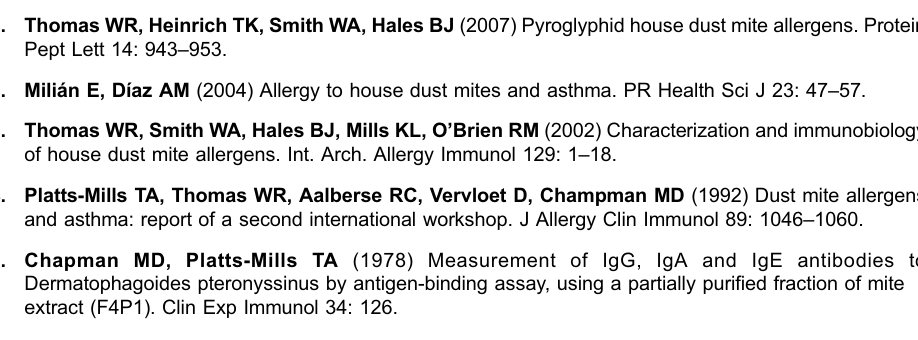
S1 Figure. Selected sequences of the Der f 1 gene showing to two distinct haplotypes: Haplotype1-rows 1, 2 and 3 (RS20, RS17, RS03_USA); haplotype2- rows 4 and 5(Df_RS27 and Df_RS30); heterozygous - rows 6 and 7 (RS26 and RS40); and gb|Der-f1 gene (GenBank Accession number X65196). S2 Figure. Selected Der p 1 gene sequences aligned in NCBI blastn. gb|Der- p1gene (GenBank accession number X65197.1).